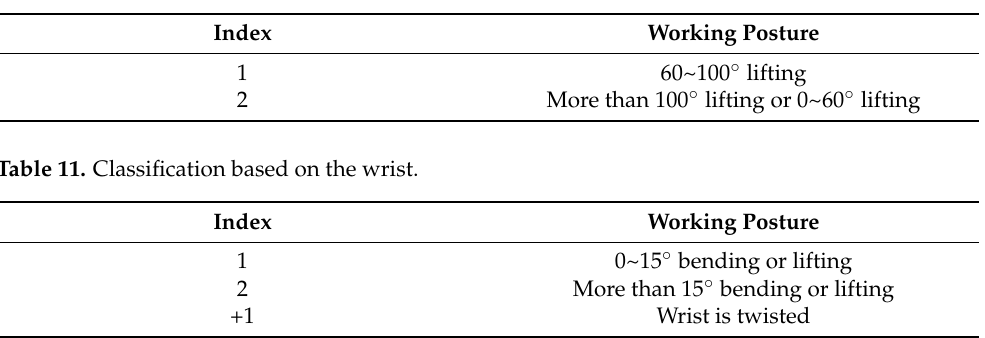
Table 10. Classification based on the lower arm posture.